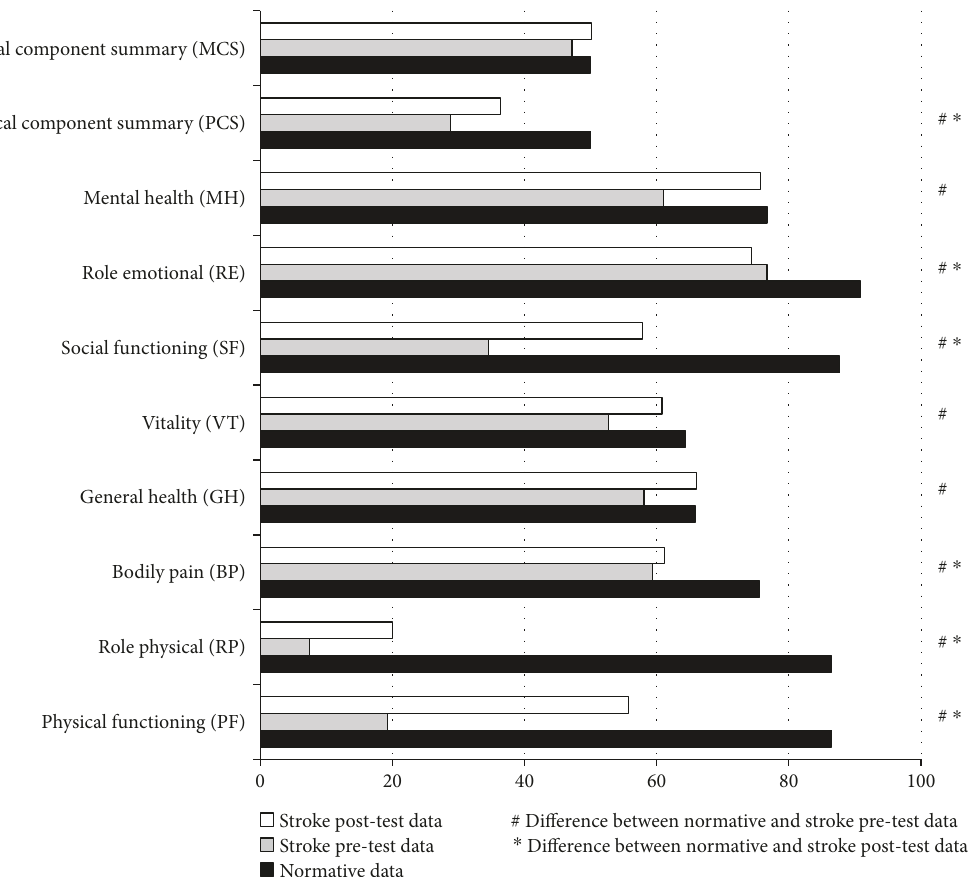
Figure 2: Comparison between stroke and normative